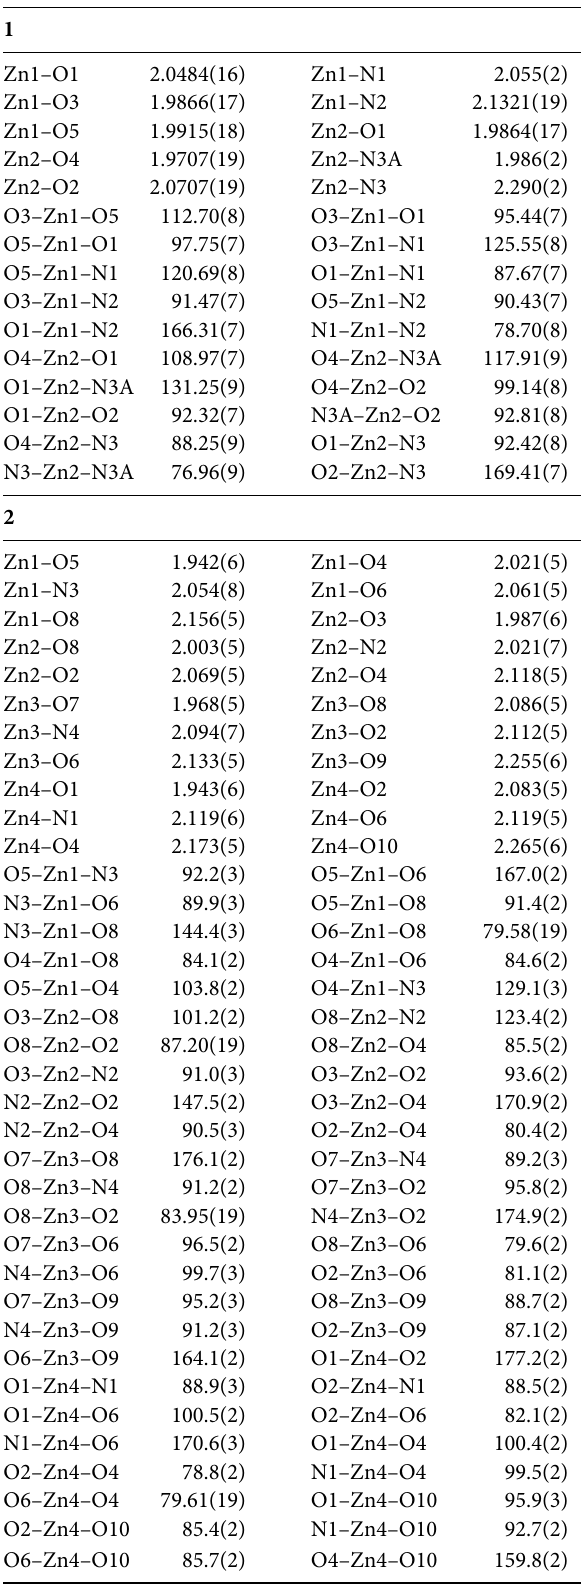
Table 2. Selected bond lengths (Å) and angles (º) for the